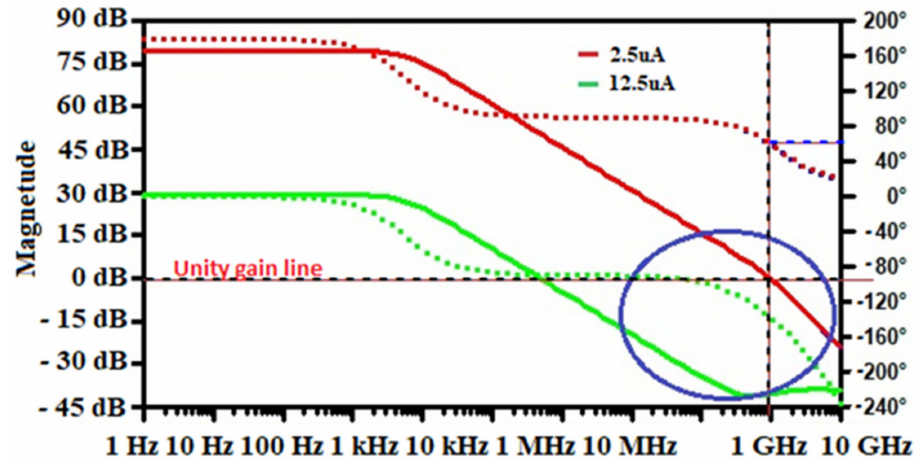
Figure 7. Influence of bias current (I bias ) on the Open-loop